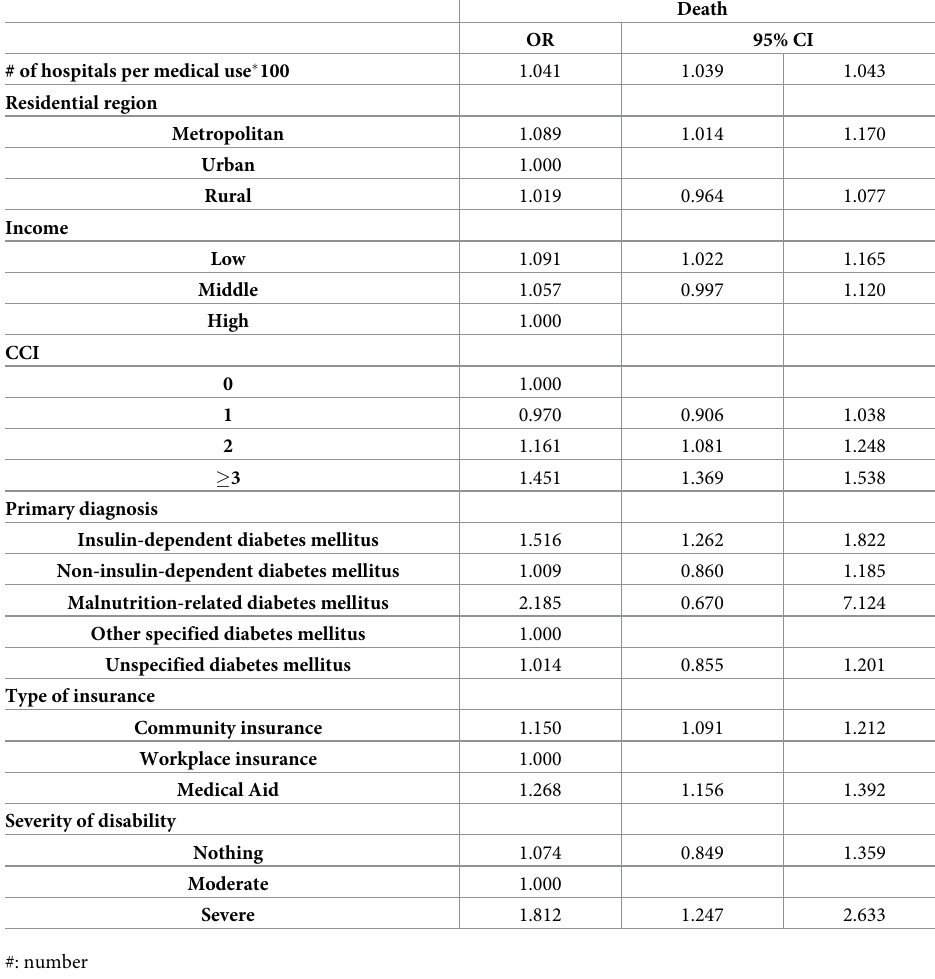
Table 2. Adjusted effect of all variable on